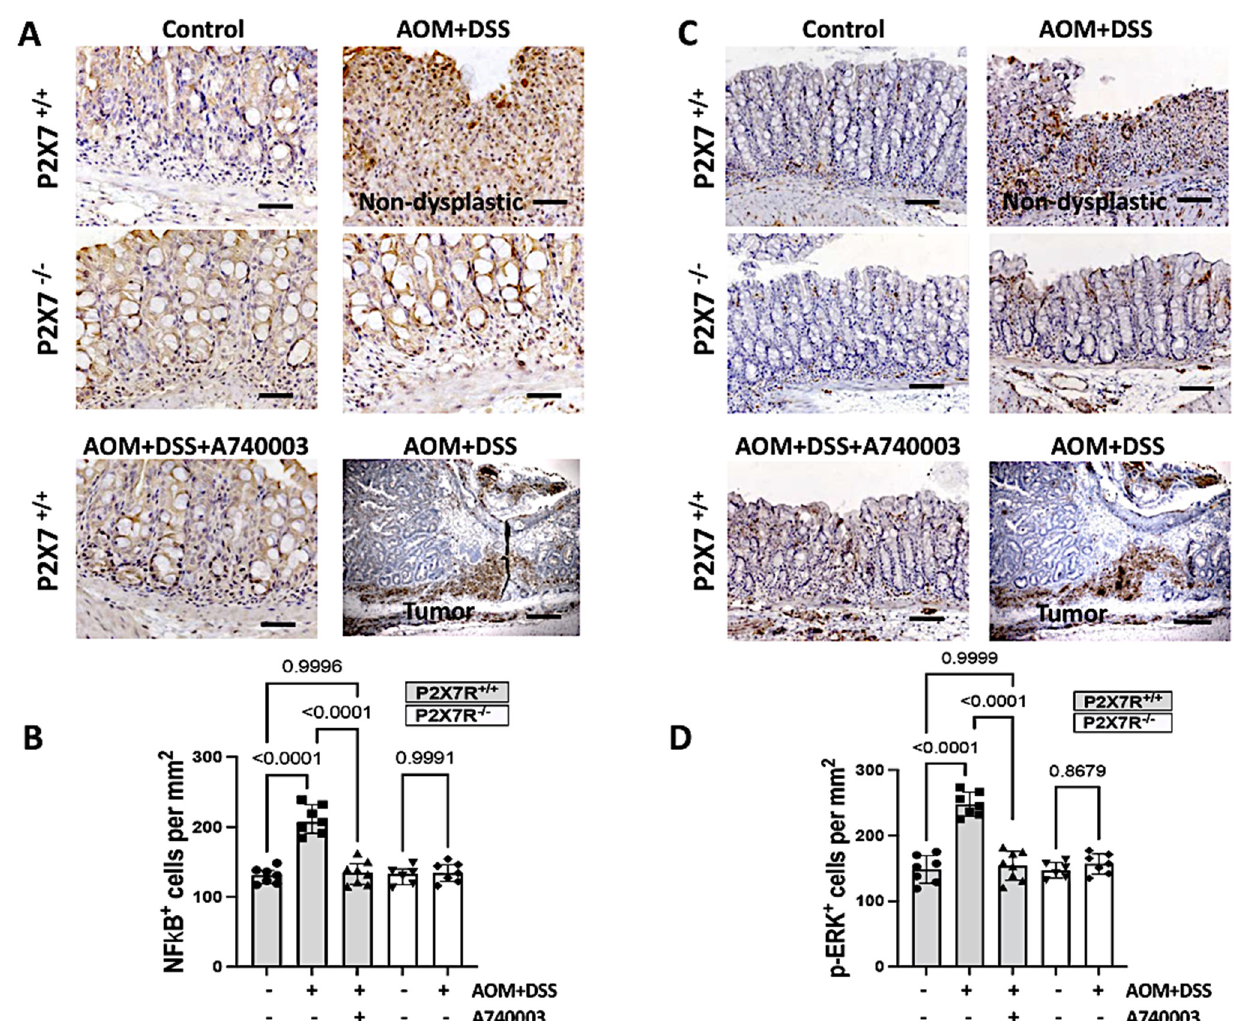
Figure 6. P2X7R blockade attenuates the expression of intracellular signaling pathways involved in cytokine production and cell survival triggered by AOM/DSS induction. The P2X7R − / − and P2X7R +/+ mice treated with the P2X7R antagonist A740003 expressed less NF-kappa B ( A , B ) and phospho-ERK ( C , D ) than the P2X7R +/+ -treated animals. Values are medians with interquartile ranges of three independent experiments, with 4–5 animals per group. The scale bars represent 20 µ m. The analysis was performed by Brown-Forsythe and Welch ANOVA tests, in which multiple comparisons were carried out using Dunnett’s T3 test. Significant values are presented.